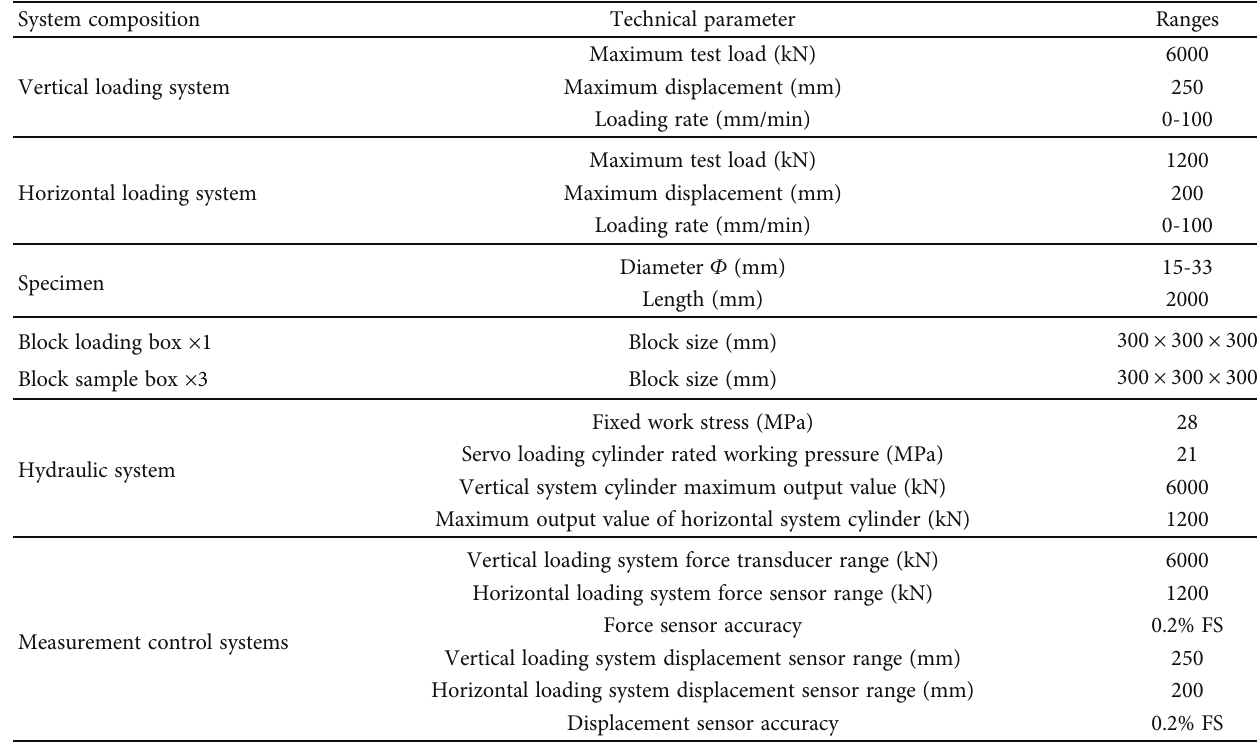
Table 1: Composition and main technical parameters of the tensile and shear test system of the combined pipe and cable structure.